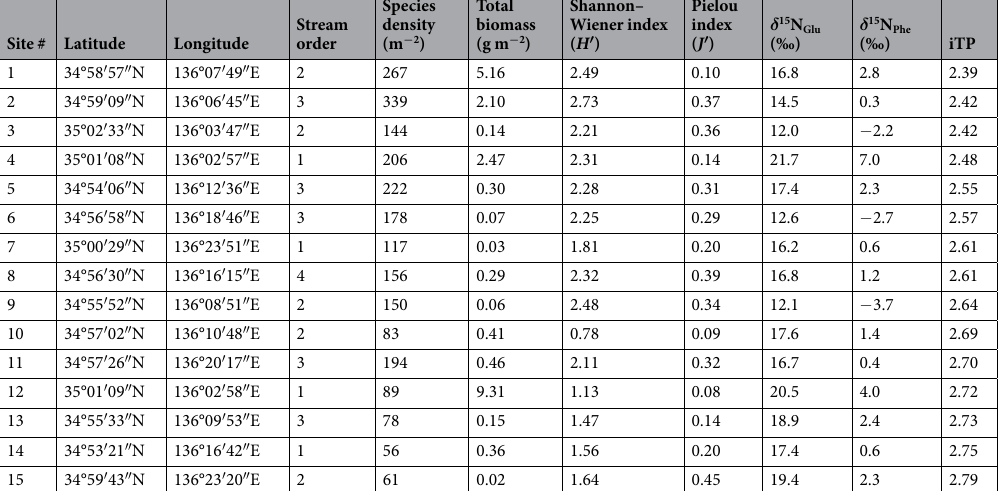
Table 1. Dataset analysed in the present study. Species density, total biomass, the individual-based Shannon– Wiener diversity index ( H ′ ), and the biomass-based Pielou evenness index ( J ′ ) were each calculated by averaging the values from two sampling replications at each